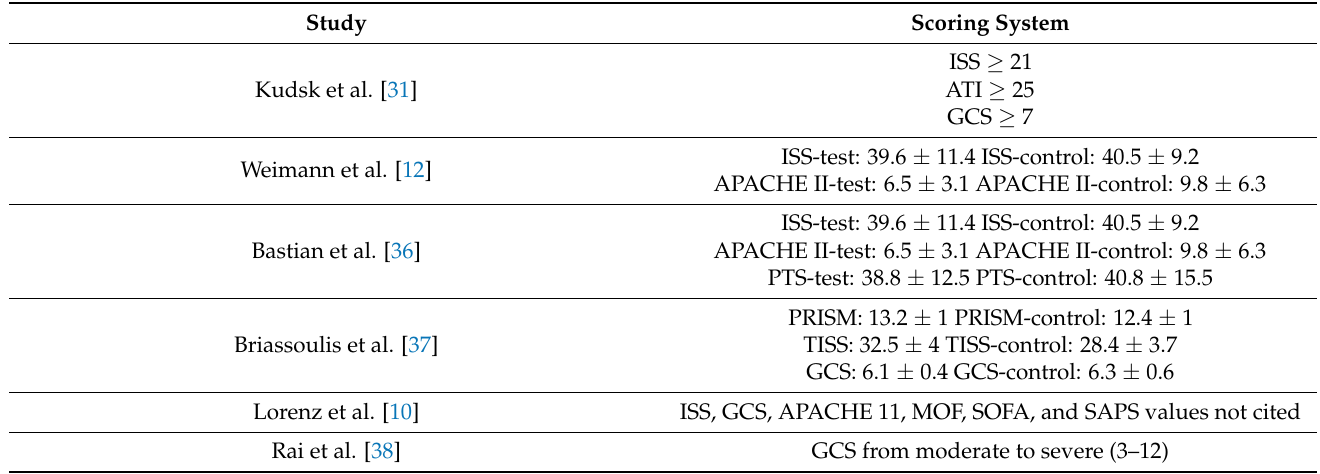
Table 5. Assessment of the patient’s clinical situation. Injury Severity Score (ISS), ATI Score (age- thrombus burden index of microcirculatory resistance), Glasgow Coma Scale (GCS), APACHE II (Acute Physiologic Assessment and Chronic Health Evaluation II), Pediatric Trauma Score (PTS), PRISM (Pediatric Risk of Mortality), and Therapeutic Intervention Scoring System (TISS).